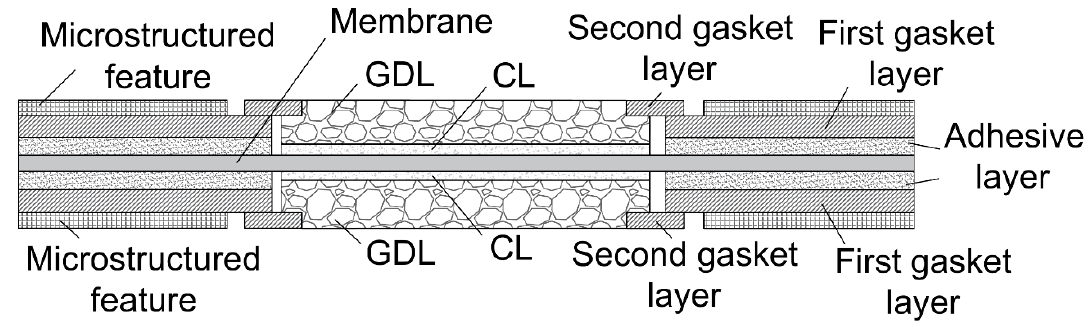
Figure 15. Rigid-protective-frame sealing structure.